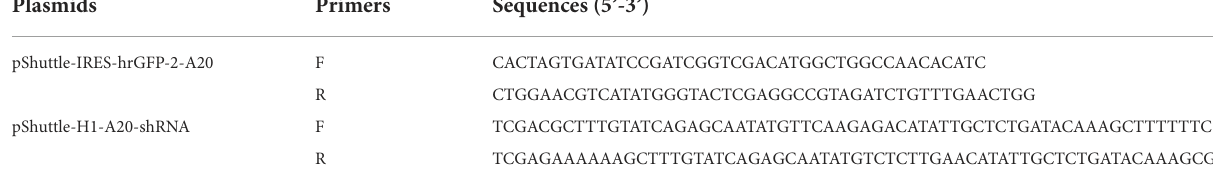
TABLE 1 A20 recombinant adenovirus construction primers.